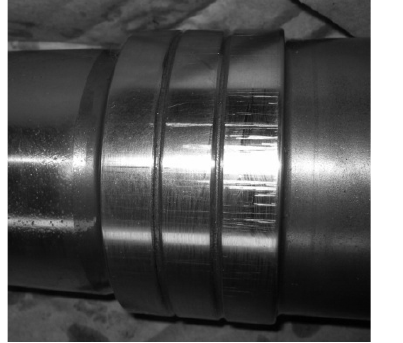
Figure 10 – Abrasive damage on the hammer piston Slika 10 – Abrazivna ošte ć enja na klipu č eki ć